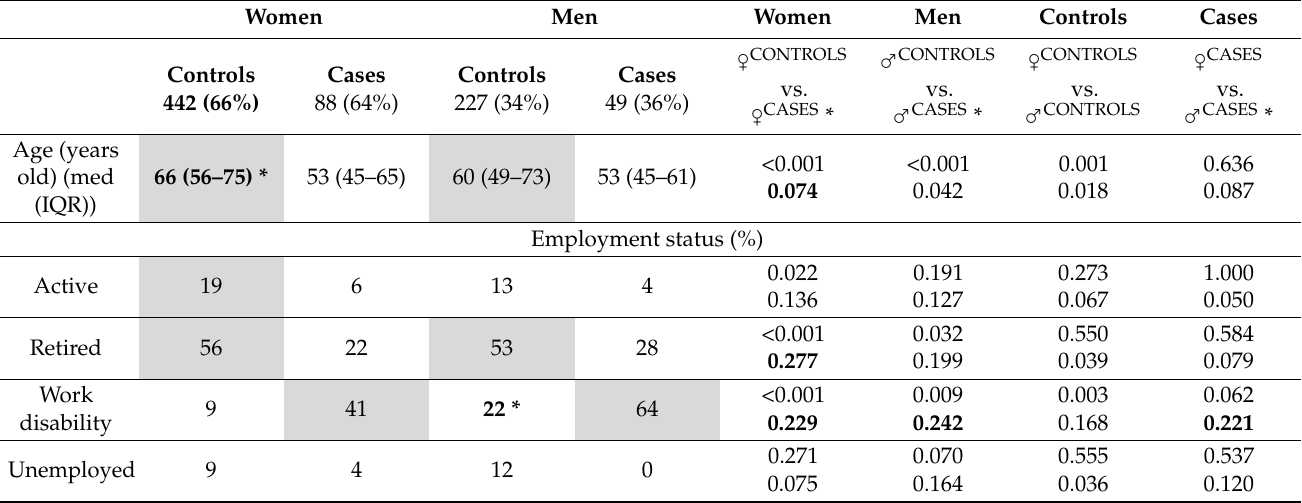
Figure 2. Odds ratio (OR) with 95% confidence intervals (95% CI) of risk factors for females ( a ) and males ( b ). ADRs, adverse drug reactions. Table 1. Socio-demographic analysis by